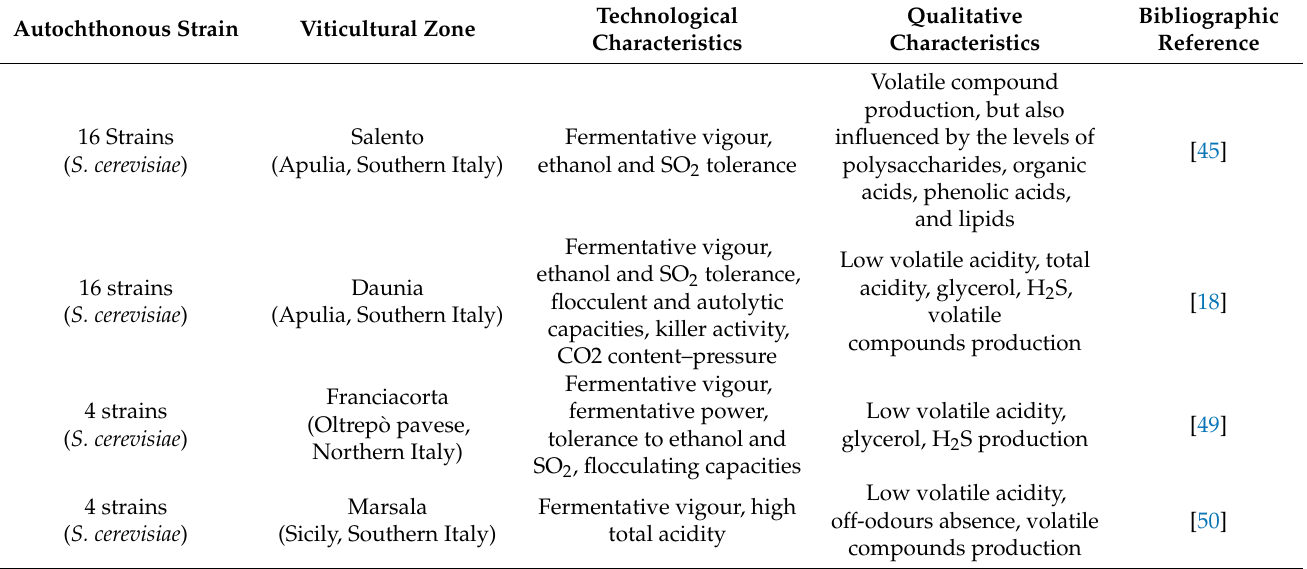
Autochthonous Strain Viticultural Zone